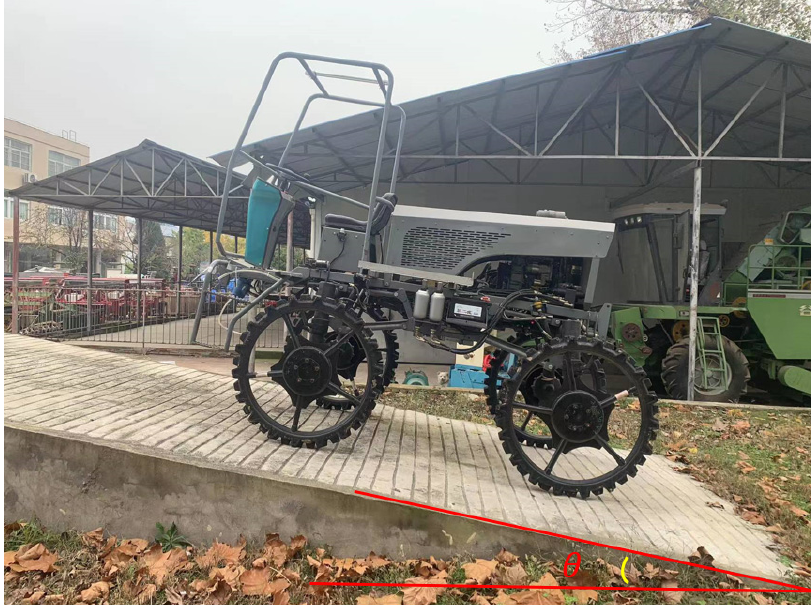
Figure 13. The climbing experiment of HGPM.